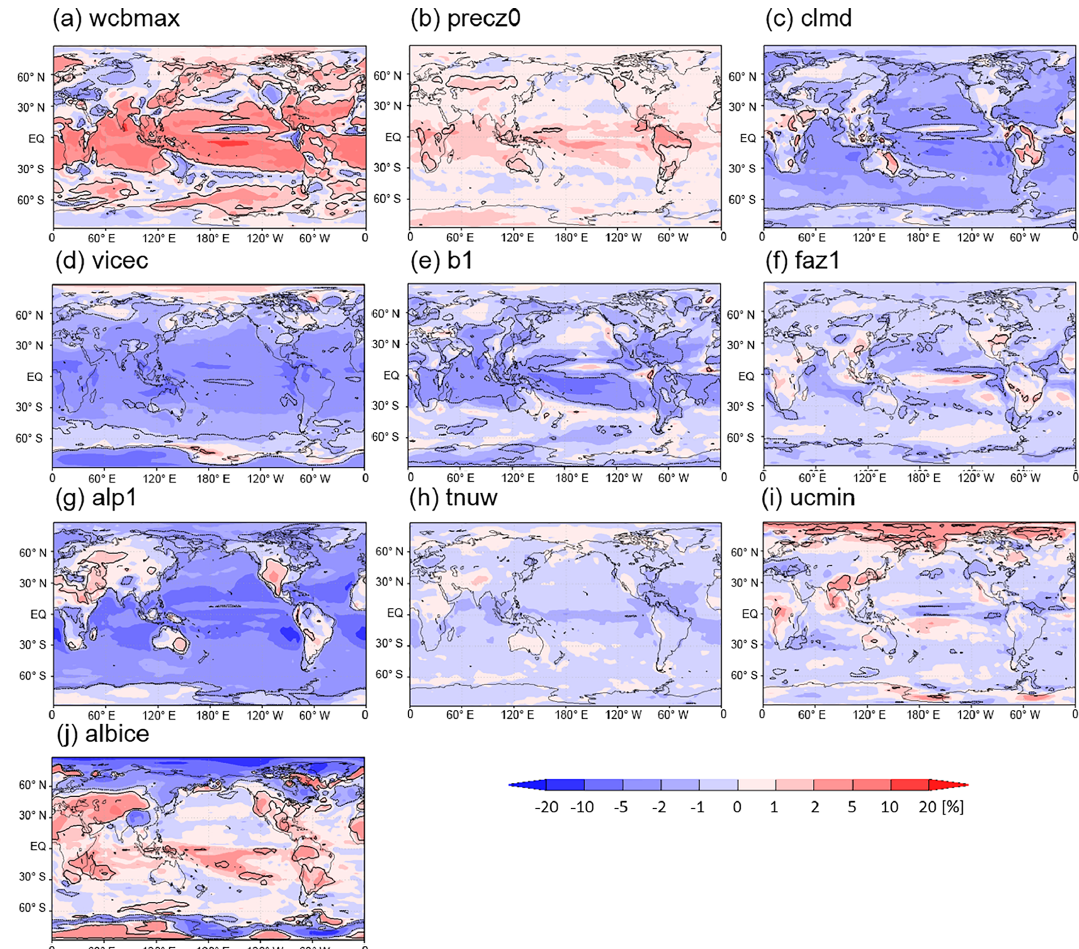
Figure A1. Regression coefficient of the annual mean ISCCP cloud amount on the tuning parameters calculated using the 56 samples of the MIROC5 PPE. The definition of the tuning parameters is shown in Table 1. The tuning parameters are normalized to the range of [0,1]. The black curves indicate the threshold of the statistical significance with the 5%